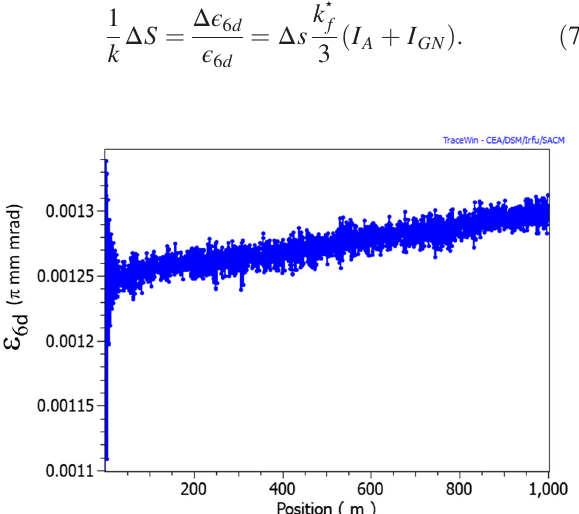
FIG. 3. Example of evolution of ϵ 6 d for N ¼ 4000 .